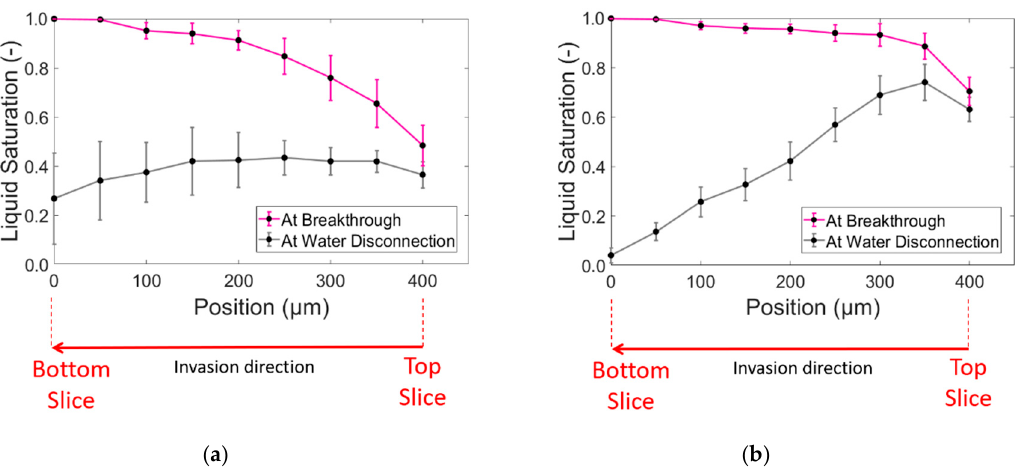
Figure 9. ( a ) Saturation profiles for the networks in Figure 8a,b (no gradient) and ( b ) for Figure 8c,d (LTH gradient). The graphs were obtained from Monte Carlo simulation of 15 variations of the pore networks, with simulation parameters as summarized in Table 1.